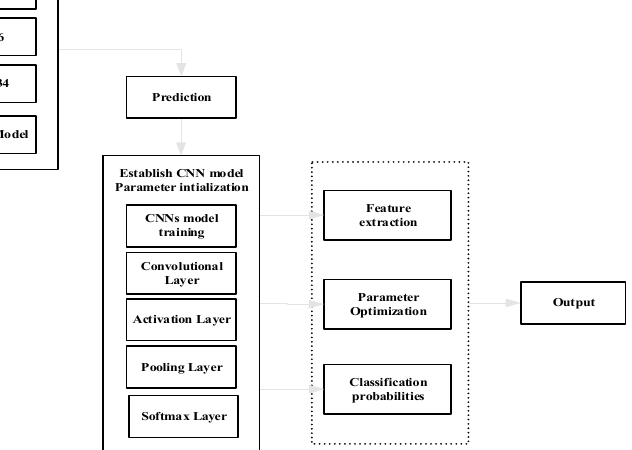
cation and regression tasks. This encompasses resizing, orienting, and color adjustments, among other things. The dataset’s size was boosted by including photographs from Google Photos. As we have used a small dataset in this paper, we needed to expand it to make it suitable for the deep learning approach. Data augmentation can be very useful for this purpose since it generates more images from each picture. Therefore, augmentation methods, such as random re-sized crop and random horizontal flip, are applied here as shown in Figure 2. Figure 2. The suggested CNN model’s architecture. Classification is a technique for extracting characteristics from a dataset. This is ac- complished by categorizing acquaintances into multiple clusters depending on features. By training it on known data, a novel model is created to predict and classify. The